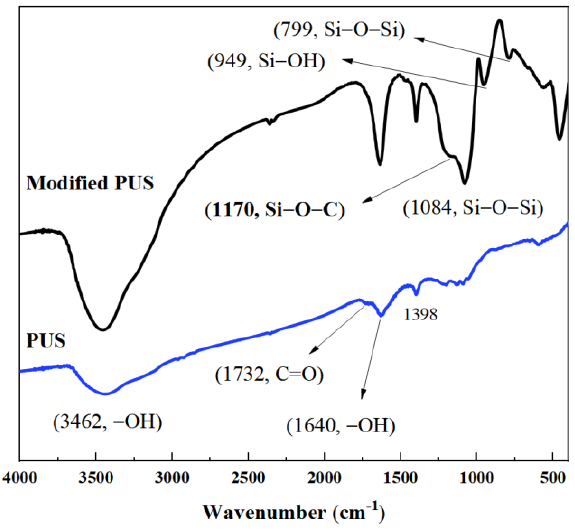
Figure 11. The FTIR spectra of PUS before and after modification.